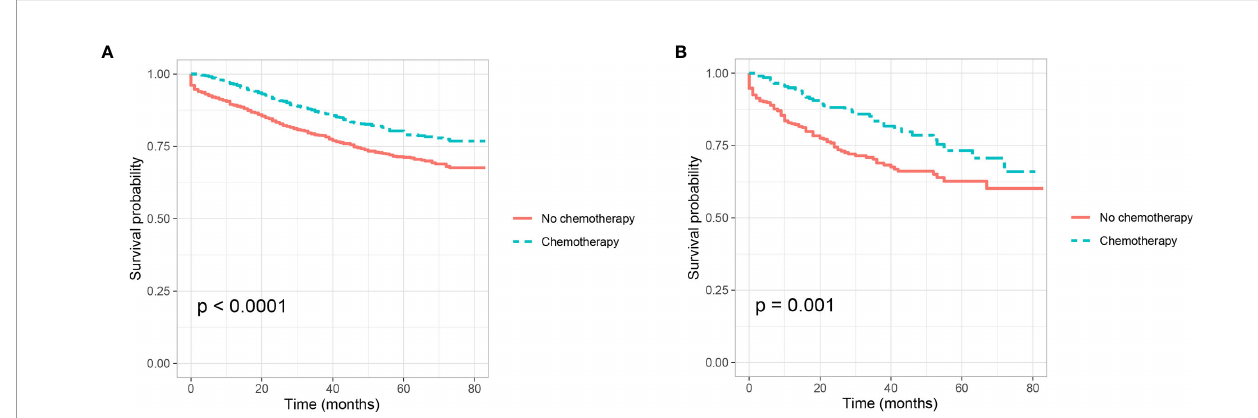
FIGURE 3 | Kaplan – Meier curves for cancer-speci fi c survival according to the receipt of chemotherapy (no chemotherapy VS. chemotherapy) in stage IIB colon cancer (A) with the presence of perineural invasion (P <0.001) and (B) without the presence of perineural invasion (P =